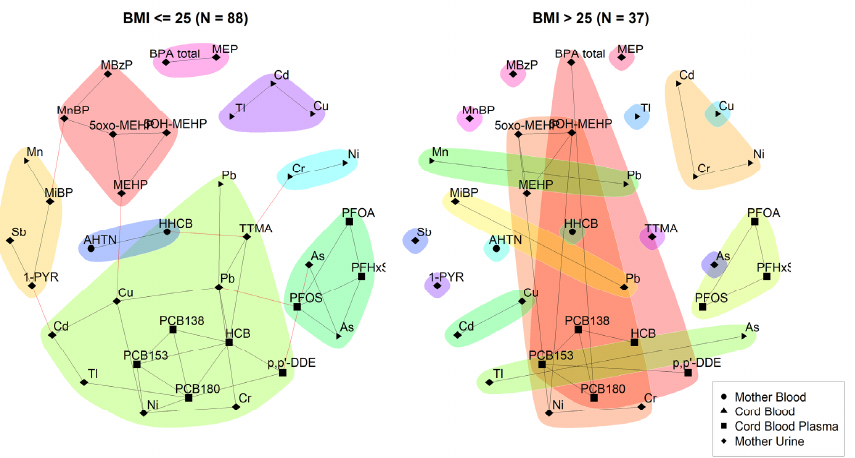
Figure 7. Unweighted network for 3xG for participants with a BMI ≤ 25 kg/m 2 and participants with a BMI > 25 kg/m 2 . The data were corrected for age and smoking. Urinary markers were standardised for creatinine and blood markers were standardised for lipids. Black lines indicate dependency between nodes (biomarkers) within a community; red lines indicate dependency between nodes in different communities.